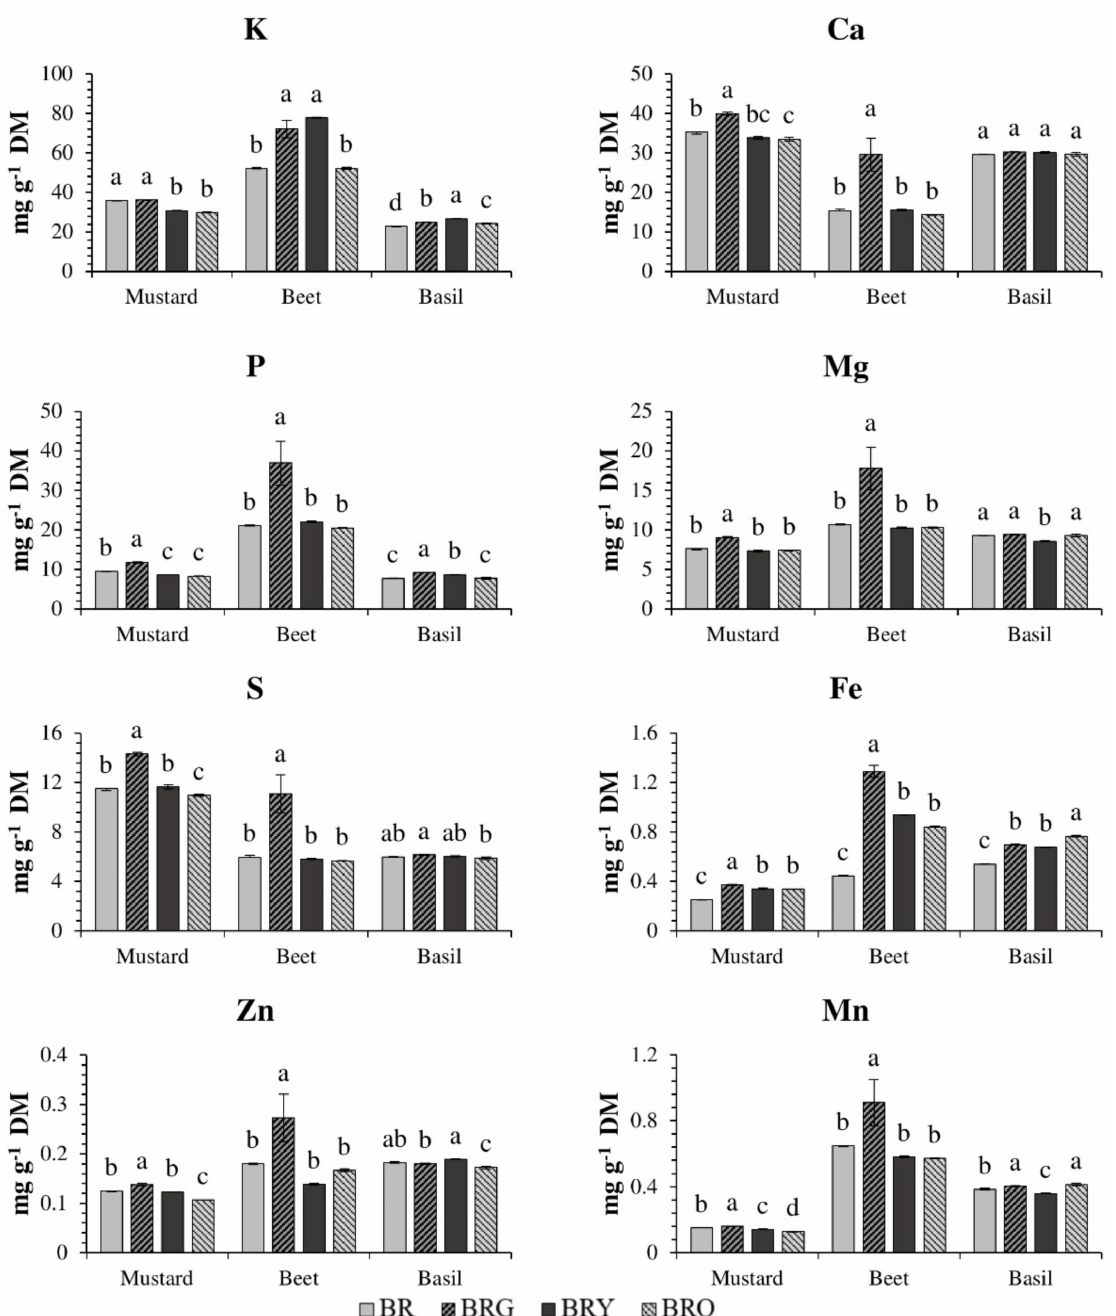
Figure 1. Content of macro-nutrients potassium (K), calcium (Ca), magnesium (Mg), phosphorus (P), and sulfur (S), and micro-nutrients iron (Fe), zinc (Zn), and manganese (Mn) in mustard, beet, and basil microgreens. BR—blue (peak = 447 nm), red (peak = 638 and 665 nm), far-red (peak = 731 nm); BRG—BR with green (peak = 520 nm); BRY—BR with yellow (peak = 595 nm); BRO—BR with orange (peak = 622 nm). Total PFD was maintained at 300 µ mol m − 1 s − 2 , changing the input of red (peak = 638 nm). Means with different letters are significantly different at the p < 0.01 level by Tukey’s honestly significant difference test. Error bars show SD. Different letters represent different